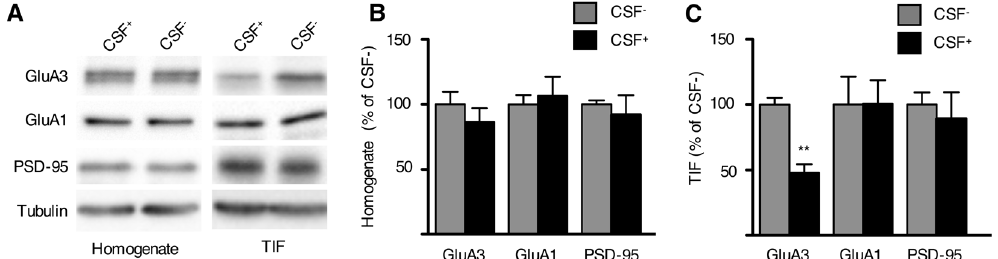
Figure 5. Neurobiological effect of GluA3 antibodies in neurons differentiated from human iPSCs. ( A ) WB analysis from homogenates and triton-insoluble postsynaptic fractions (TIF) of neurons differentiated from human iPSC and incubated for 24 hours with CSF with (CSF + ) or without (CSF − ) anti-GluA3 antibodies (dilution 1:100). ( B , C ) The histogram shows the quantification of the expression levels of GluA3, GluA1 and PSD-95 in homogenate ( B ) and TIF ( C ), normalized on tubulin and expressed as % of CSF − . N = 5 *** p < 0.001, unpaired Student’s